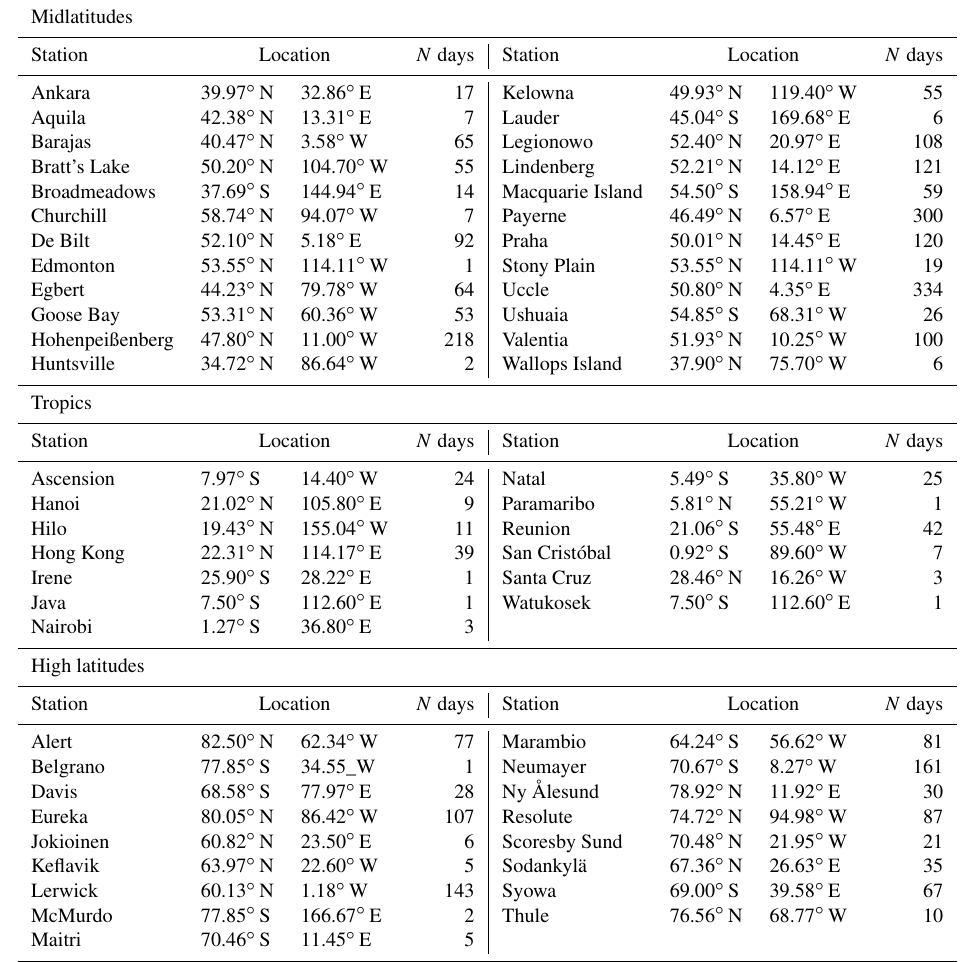
Table A1. Ozonesonde stations used for the IASI O 3 validation. The term “ N days” represents the number of measurements matching the coincidence